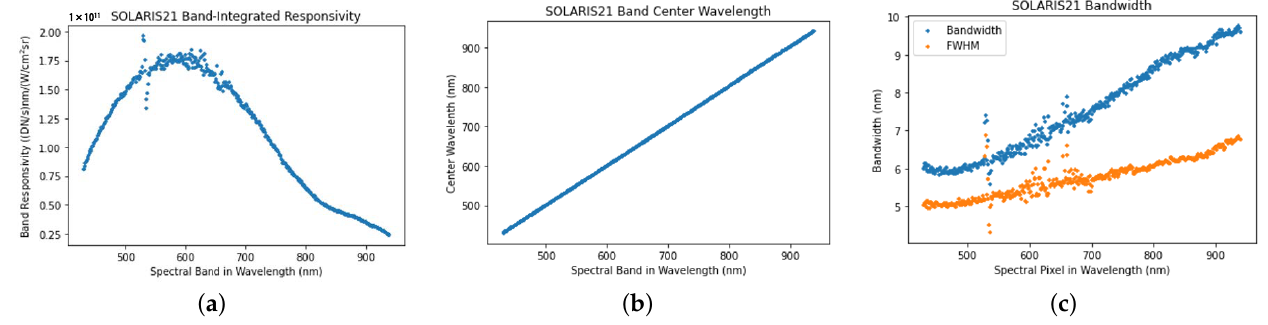
Figure 14. The characterized ( a ) band-integrated responsivity, ( b ) center wavelength, and ( c ) band- width & FWHM of SOLARIS bands (detectors).